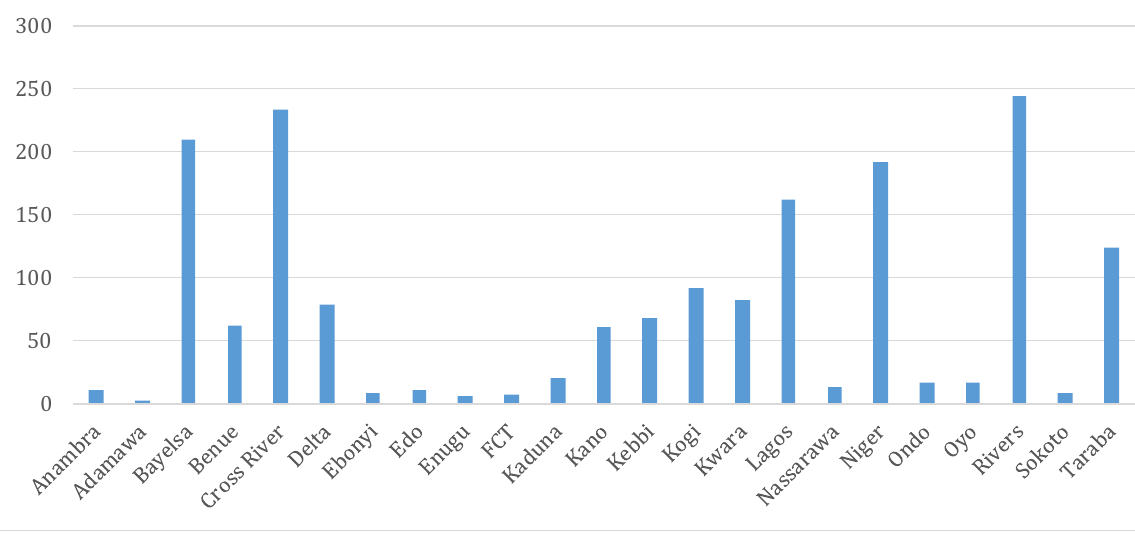
Source : Extrapolated data from Ukoji and Ukoji